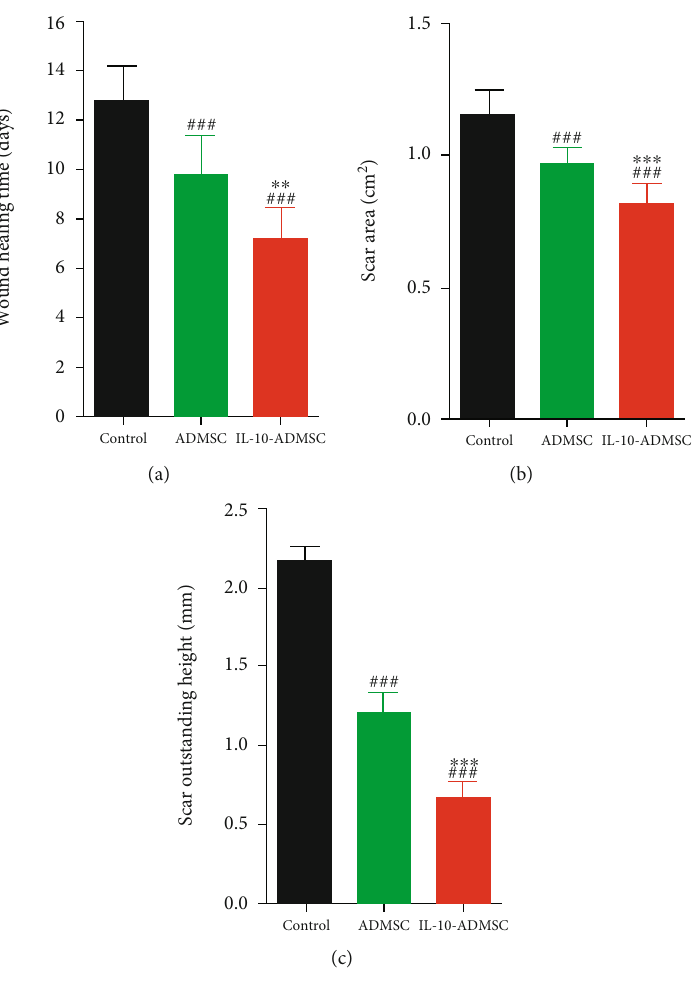
Figure 6: IL-10-modi fi ed ADMSC prevented hypertrophic scar formation. (a) The time of wound healing time in di ff erent group in rabbit ear hypertrophic scar model. (b) After 28 days of treatment in di ff erent ways, the comparison of scar area in di ff erent group; (c) after 28 days of treatment in di ff erent ways, the scar outstanding height of hypertrophic scar were statistically compared. n = 10 ; data was expressed as ( SD ± mean ); P value was calculated by one-way ANOVA; ∗∗ was P < 0 : 01 and ∗∗∗ was P < 0 : 001 vs. ADMSC group; ### was P < 0 : 001 vs. control